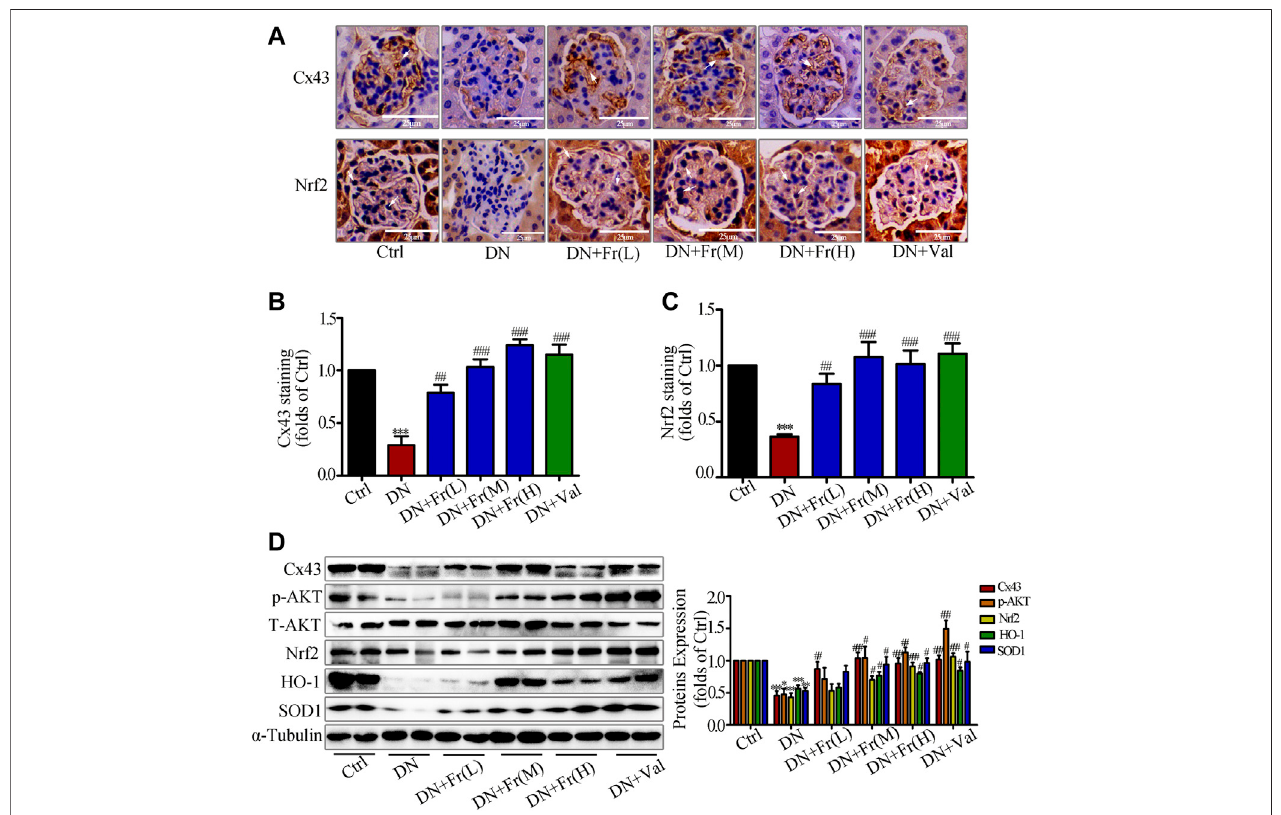
FIGURE8 | Frstimulated the activation ofNrf2/ARE signaling pathway byup-regulatingCx43 expression in kidney tissues. (A) The expression of Cx43 and Nrf2 in the glomeruli were shown by immunohistochemical staining (×200 magni fi cation). Bar: 50 μ m, n = 6. (B-C) Statistical analysis of Cx43 and Nrf2 protein expression. (D) ThelevelsofCx43,p-AKT,Nrf2,HO-1,andSOD1inkidneytissuesofdb/dbmiceweredetectedbythewesternblotassay.Independentexperimentswereperformedat least three times with similar results. * p < 0.05, ** p < 0.01, *** p < 0.001 vs . Ctrl; # p < 0.05, ## p < 0.01, ### p < 0.001 vs.